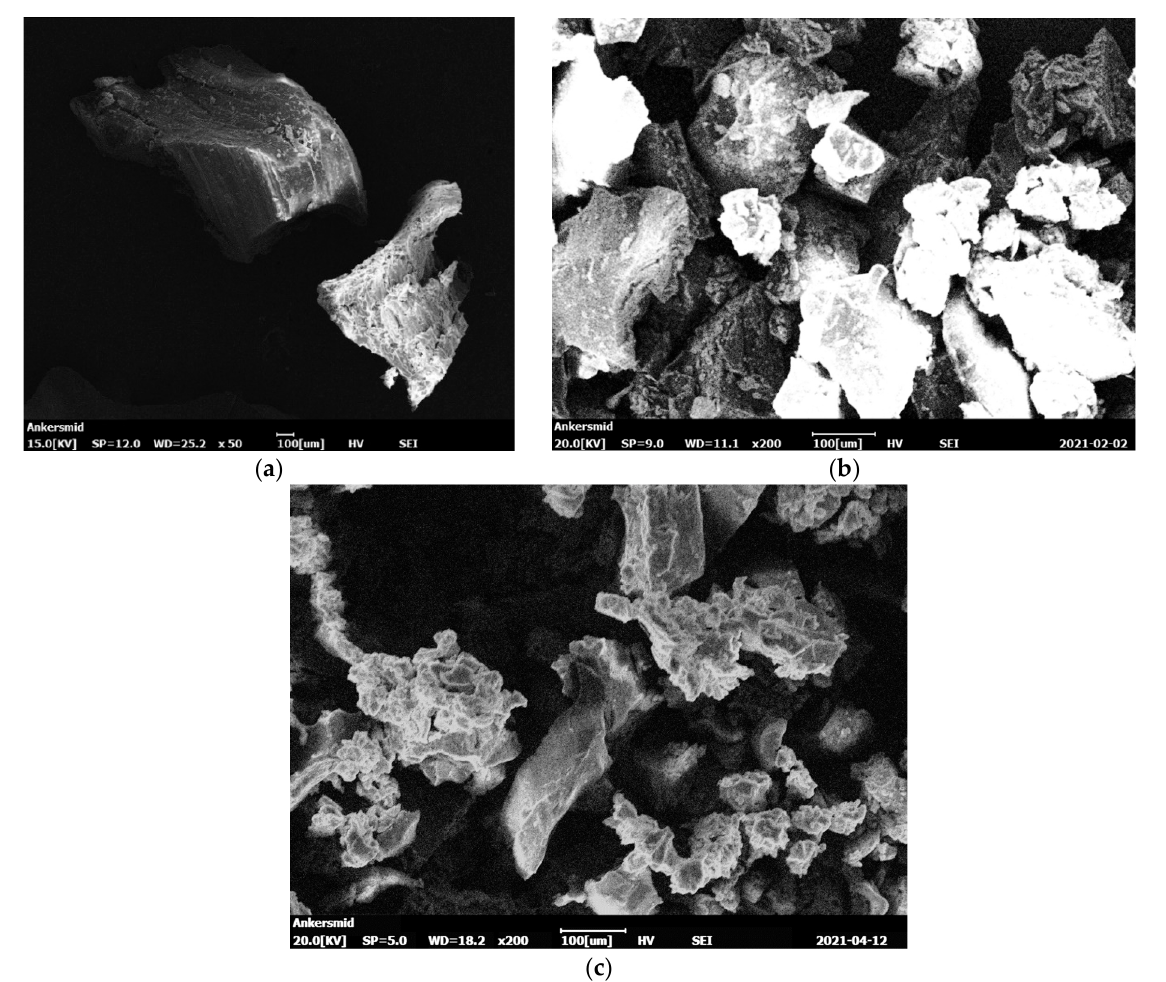
Figure 1. SEM images of the CR particles at 100 µm scale: ( a ) mechanical, ( b ) cryogenic and ( c ) waterjet.